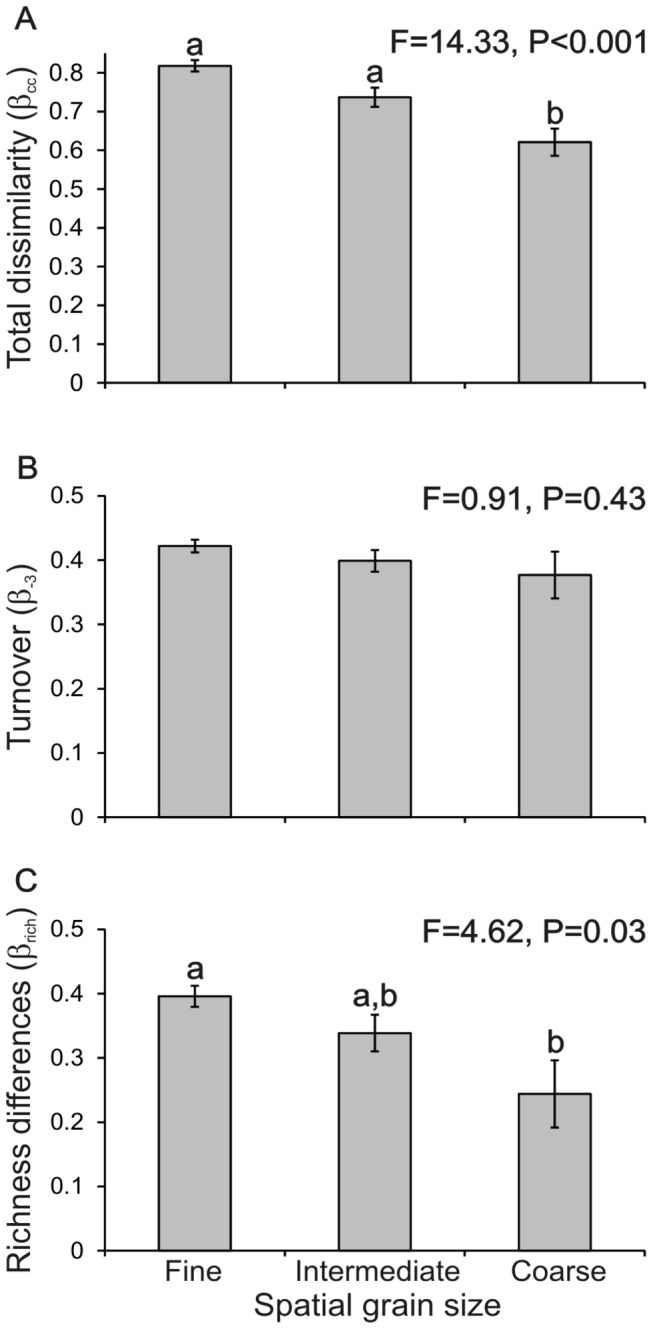
Components of dissimilarity at three spatial grain sizes.The figure shows mean total dissimilarity (A), dissimilarity derived from species turnover (B), and dissimilarity derived from richness differences (C) for terrestrial vertebrates on the Isthmus of Tehuantepec. Error bars are standard errors. ANOVA results are included, equal low case letters indicate no difference in pairwise comparisons.